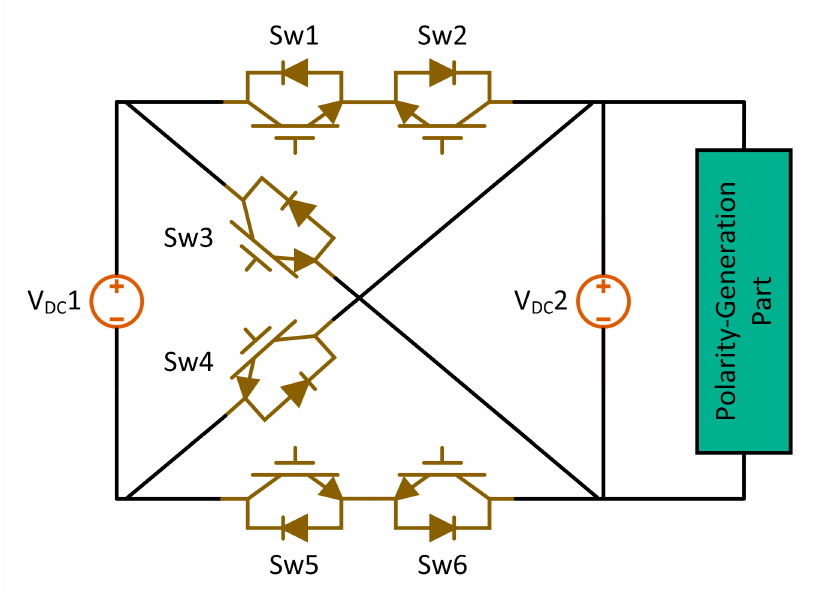
Figure 15. Topology of crisscross cascaded multilevel